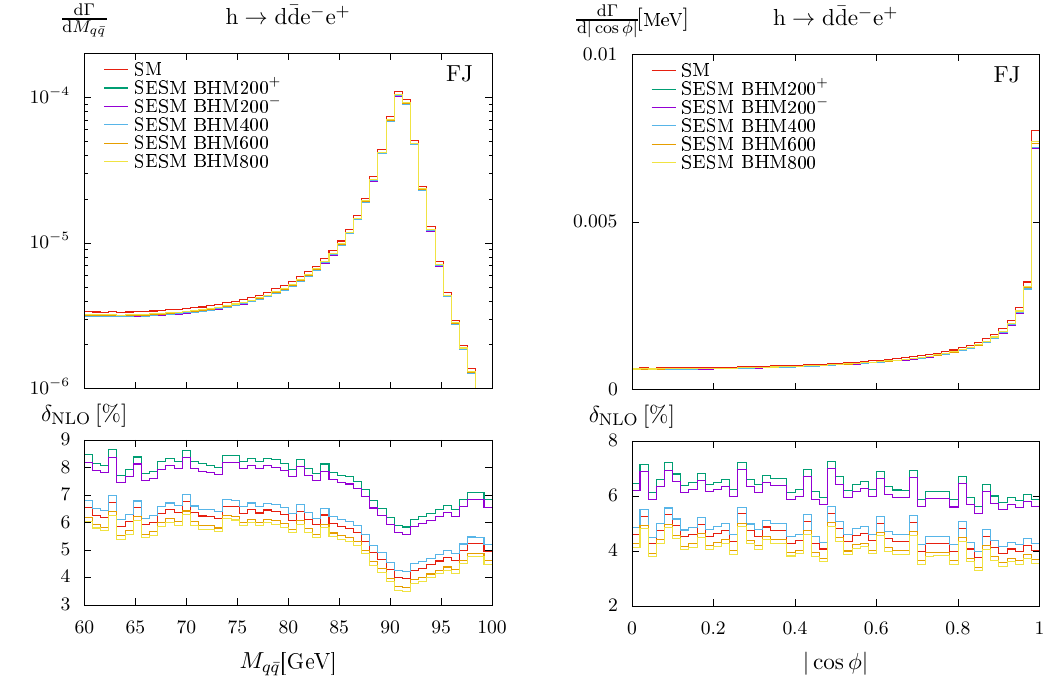
Figure 23 . Invariant-mass and angular distributions for the neutral-current semi-leptonic decay h ! d(cid:22)de (cid:0) e + , in the FJ renormalization scheme for the various SESM scenarios. In (cid:12)gure 23 we depict di(cid:11)erential distributions for the neutral-current (cid:12)nal